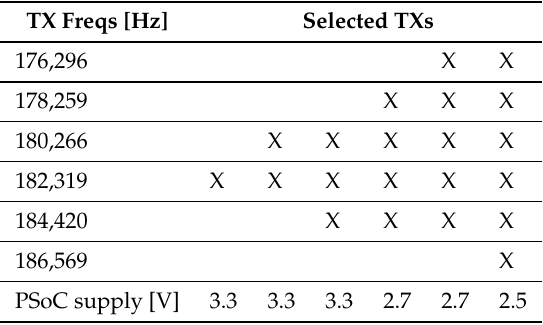
Table 1. Operating frequencies of TXs and PSoC power